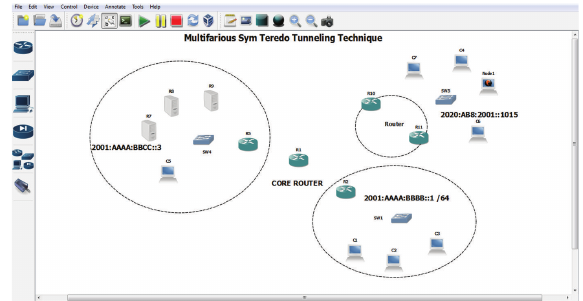
Figure 3: Multifarious Sym Teredo architecture using real-time simulation with